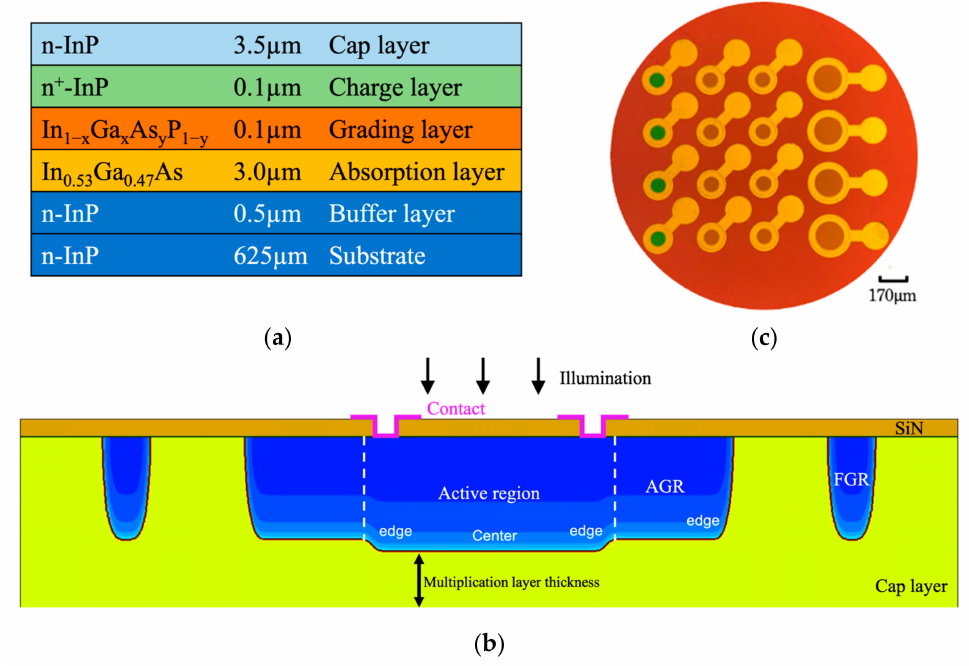
Figure 1. ( a ) Epitaxial layer structure of SAGCM APD; ( b ) schematic diagram showing the active region, AGR, and FGR, formed by Zn diffusions in the cap layer; ( c ) micrograph of the finished APD